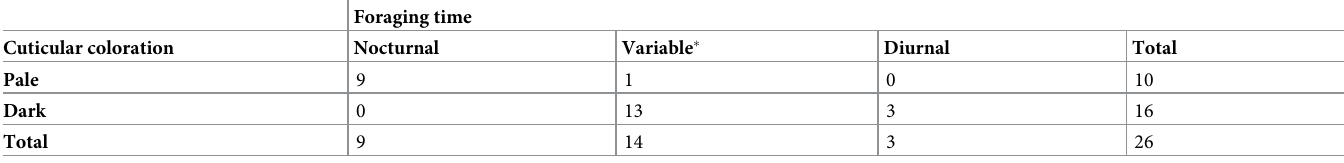
Table 2. Association between color and activity period based on data in Table 1. Pale species have a brightness (B) value > 65 and dark species have a B value < 60 as measured in Adobe Photoshop (see text). Foraging